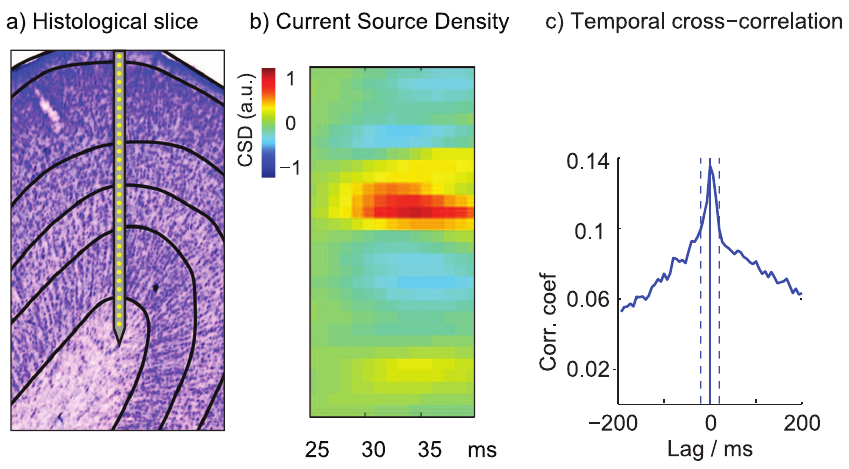
Figure 7. Experimental methods. ( a ) Example recording site with lines indicating layer boundaries and a schematic drawing of the 32-channel probe. ( b ) Current source density (the second spatial derivative of the LFP) in response to a full-field flash stimulus, showing a strong current sink in layer IV and to a lesser degree in layer VI. CSD was used to assign layer boundaries. ( c ) Cross-correlation for one pair of cells across time, binned at 6.7 ms. Correlations fall off quickly as the time lag increases with a central peak extending + 20ms indicated by dashed